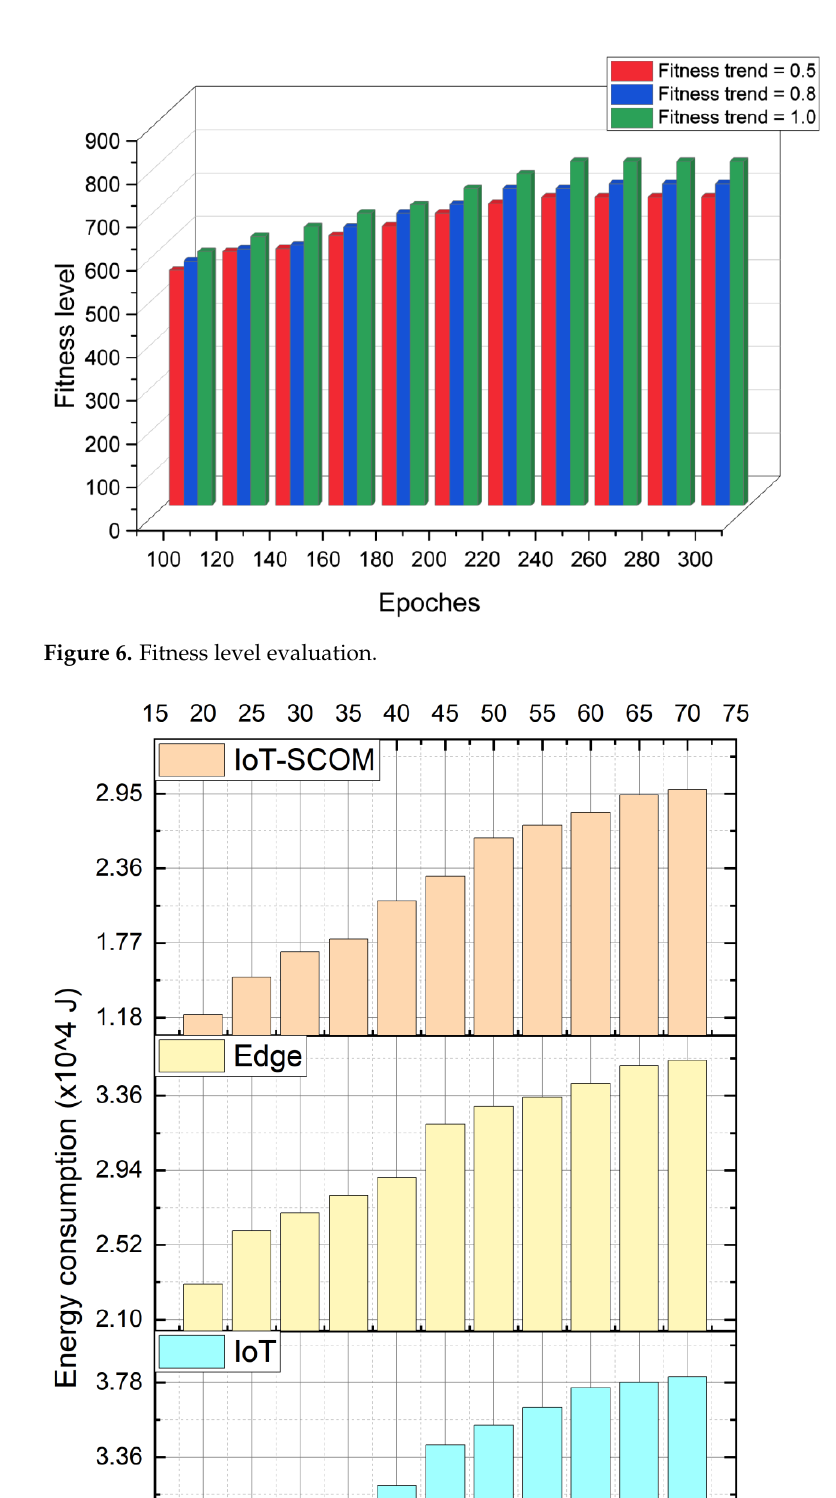
Table 2. The mean response period (sec) of the proposed IoT-SCOM.